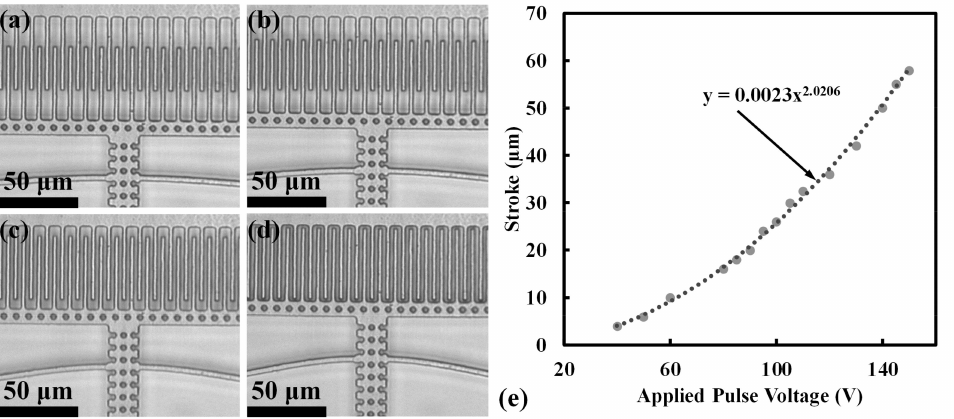
Figure 12. Effect of applied voltage to maximum displacement observed through stroboscopic imaging set-up at ( a ) 90 V, ( b ) 110 V, ( c ) 130 V, ( d ) 150 V, and ( e ) stroke is plotted against the applied voltage, and it was observed to have a square dependence on applied voltage which agrees with the device